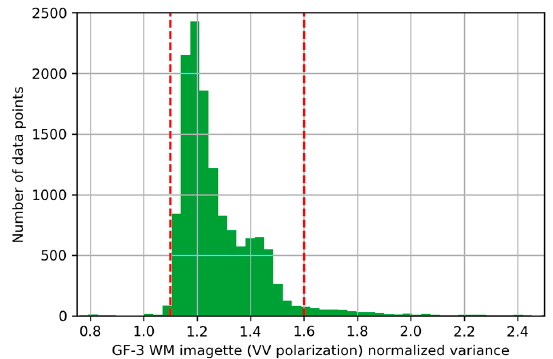
Figure 3. Histogram of normalized variance computed from GF-3 WM imagettes (in VV polarization) for the period from January to October 2017. Table 1. Information on GF-3 WM data for different incidence angle modes.